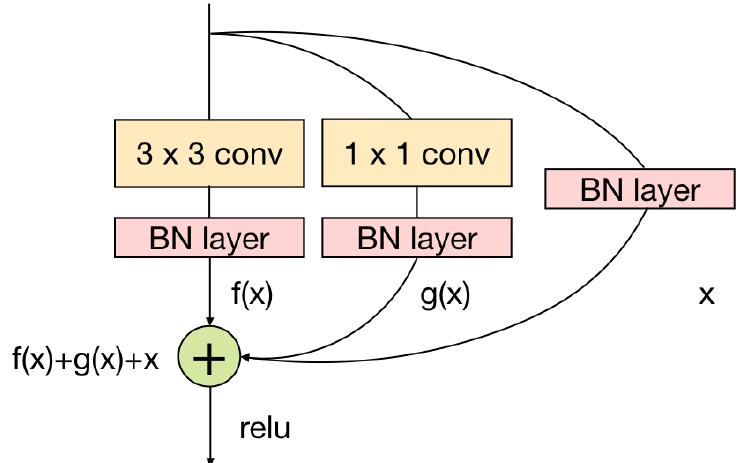
Figure 2. The RepVGG module [39]. A RepVGG module was comprised by a 3 × 3 kernel branch, a 1 × 1 kernel branch and an identity